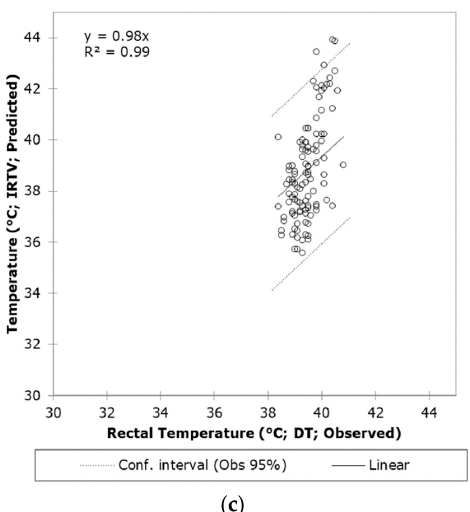
Figure 3. Linear regressions comparing results from ( a ) rectal vs. skin temperatures measured manually using a digital thermometer (DT), ( b ) observed skin temperature (manual) vs. temperature from the infrared thermal video analysis (IRTV), and ( c ) observed rectal temperature (manual) vs. temperature from the IRTV analysis. Abbreviations: Obs: observed, Conf: Confidence.